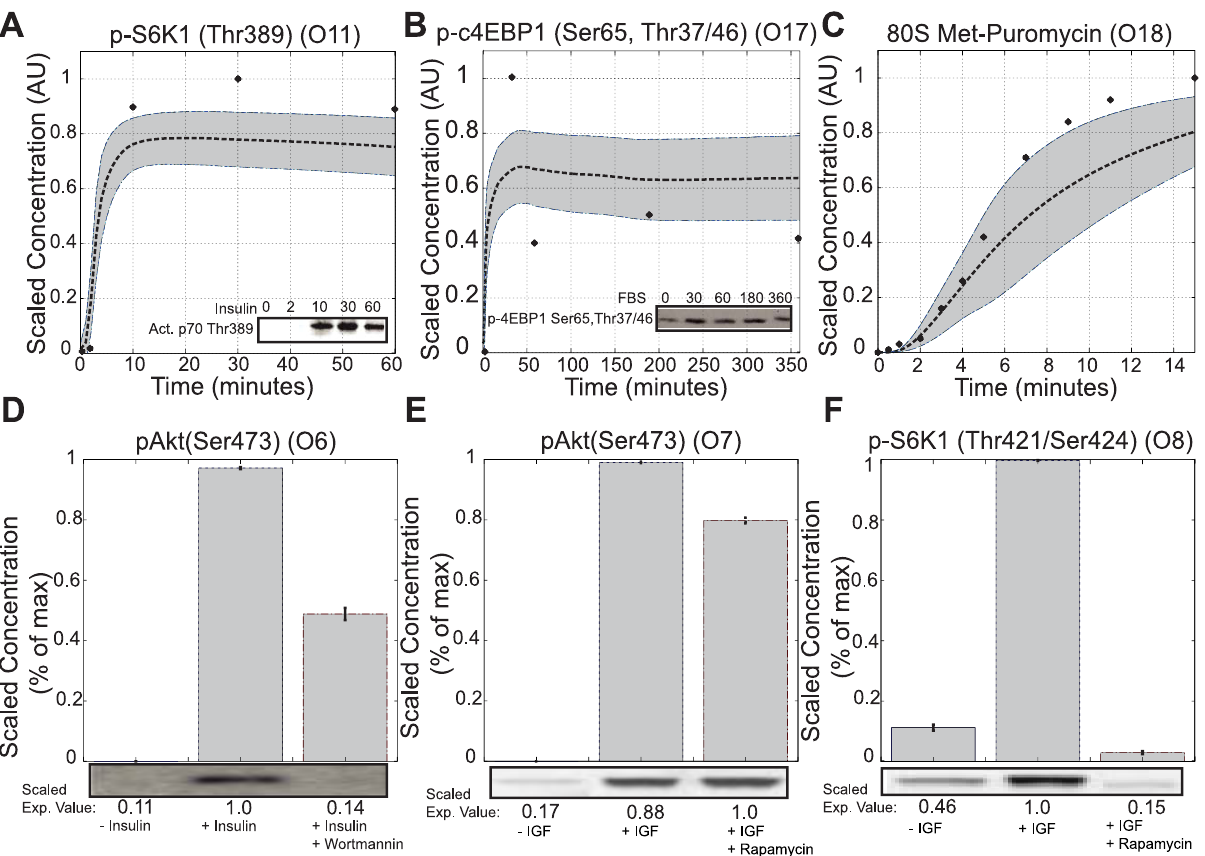
Figure 3. Ensemble performance against selected training objectives (N=400). Dotted lines represent the simulation mean of the ensemble, while the shaded region denotes the 99.9% confidence estimate for the mean. The solid dots represent the scaled experimental data. A. Time course data for p70S6K1 phosphorylation in response to insulin stimulation (L6 Myotubes). B. Time course data for c4EBP1 phosphorylation in response to FBS (RhoE 3T3 cells). C. In vitro time course of the 80S complex measured by puromycin assay (rabbit reticulocyte). D. pAkt(Ser473) levels at 20 minutes in the presence and absence of insulin and wortmannin (393T cells). E,F. pAkt(Set473) and activated p70S6K1 levels at 15 minutes in the presence and absence of insulin-like growth factor (IGF) and rapamycin (C2C12